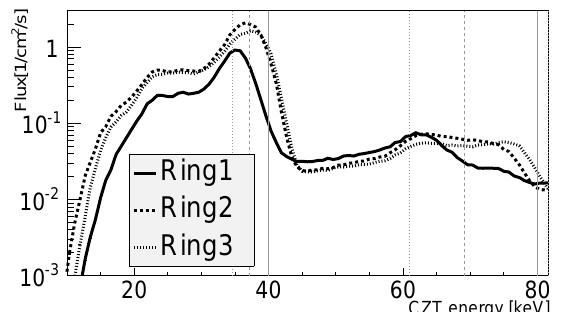
Figure 2: Energy spectra after Compton scattering of a 40 / 80 keV X-ray beam. Vertical lines: incoming beam energy (solid), energy after 90 ◦ scattering (dashed), and energy after 180 ◦ scattering